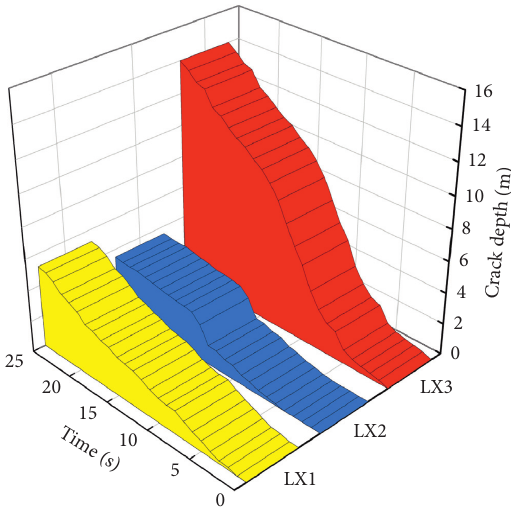
Figure 5: Fracture development of uncaved